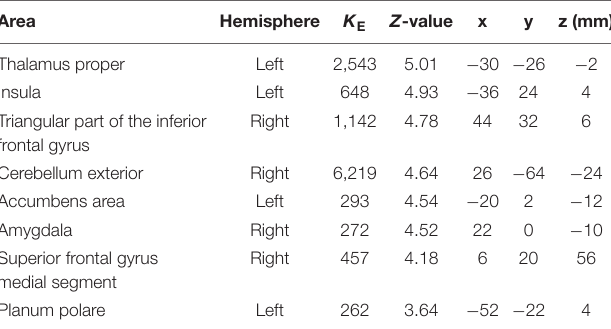
Regions of significance after family wise error cluster levels (p <